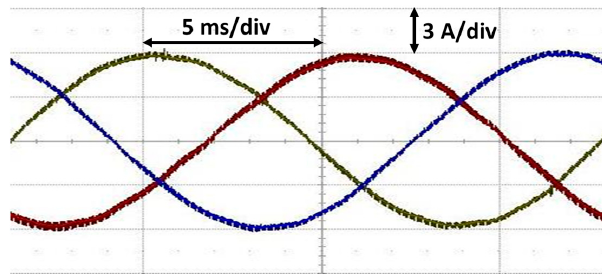
Figure 20. Input currents for the prototype machine.